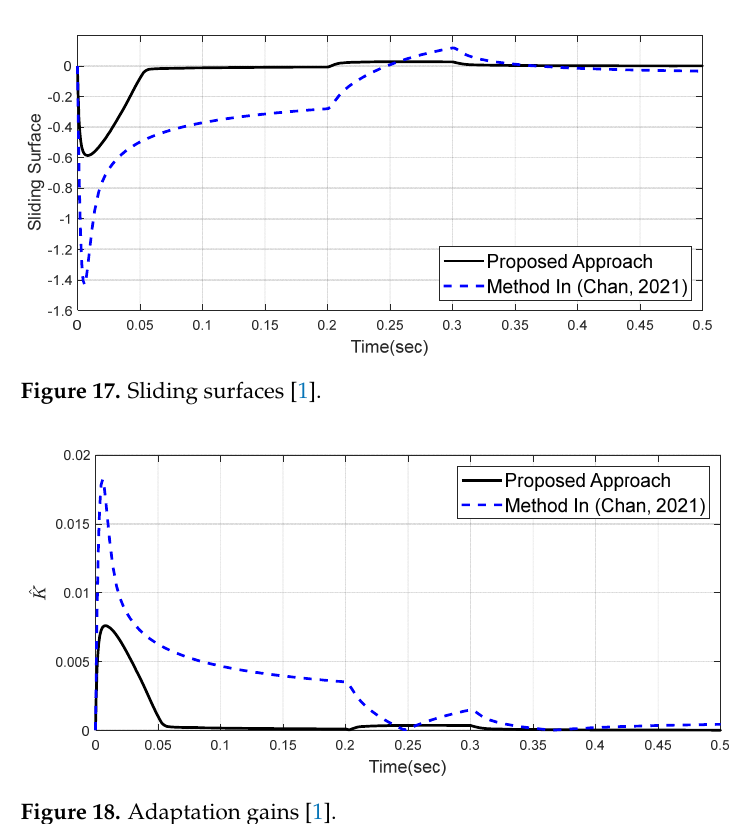
Table 4. Comparing the responses of the DBC system under the conditions of scenario